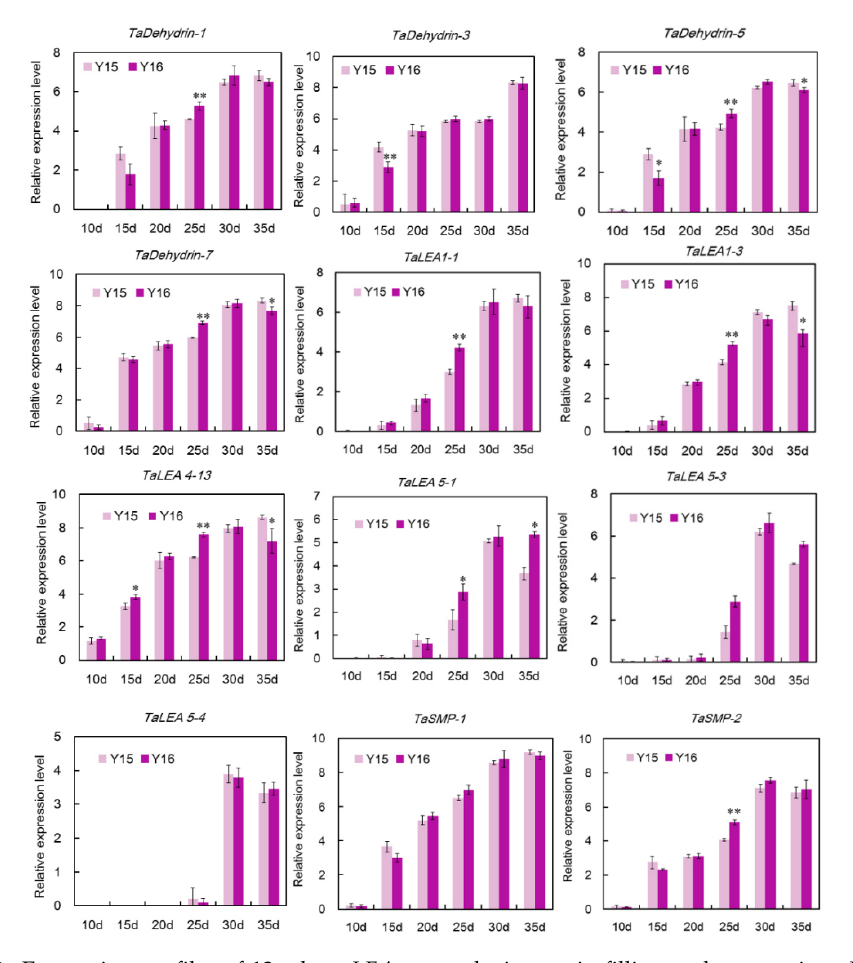
Figure 6. Expression profiles of 12 wheat LEA genes during grain filling and maturation. Purple and light purple columns indicate Yangmai16 and Yangmai 15, respectively. Values represent means ± standard deviation of three replicates. Asterisks reveal the gene significantly higher or lower in Yangmai 16 than in Yangmai 15 by t -test (* p < 0.05, ** p < 0.01).